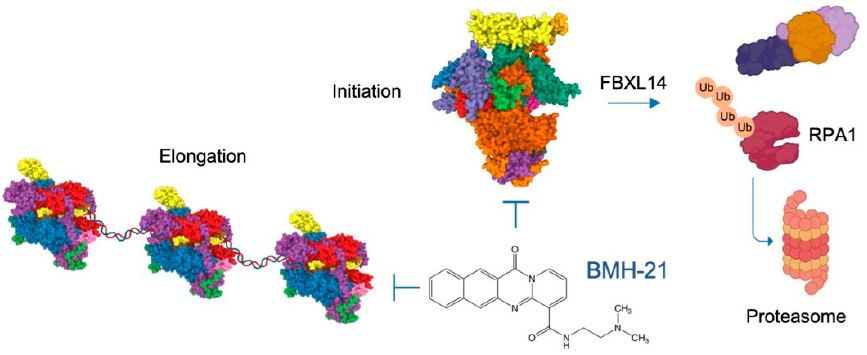
Figure 4. Mechanisms of action of the BMH-21 class of molecules. BMH-21 blocks Pol I transcription initiation, promoter escape, and elongation. This activates consequent destruction of RPA1 mediated by the F-box E3 ligase FBXL14. Human Pol I complexes are depicted from Protein Data Bank structure, PDB:7OB9 and 7OBA. Ref. [51].